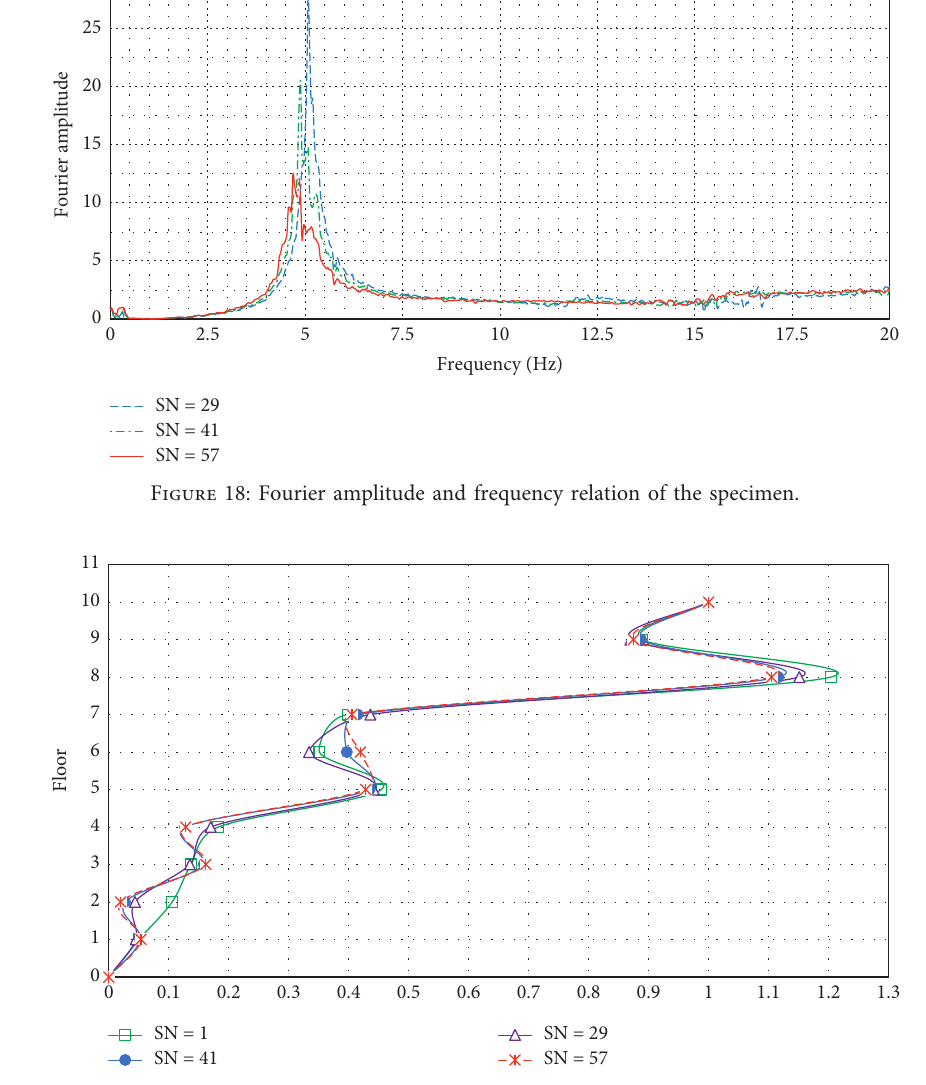
Figure 19: Basic modes of the